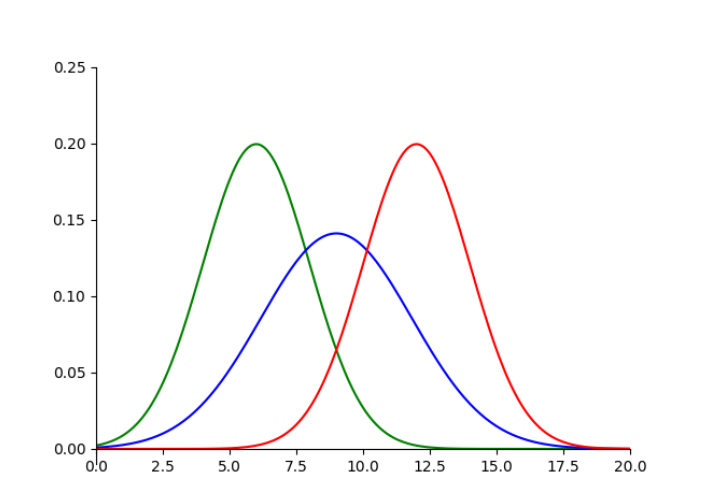
Figure 8. Domain transfer via Reform.